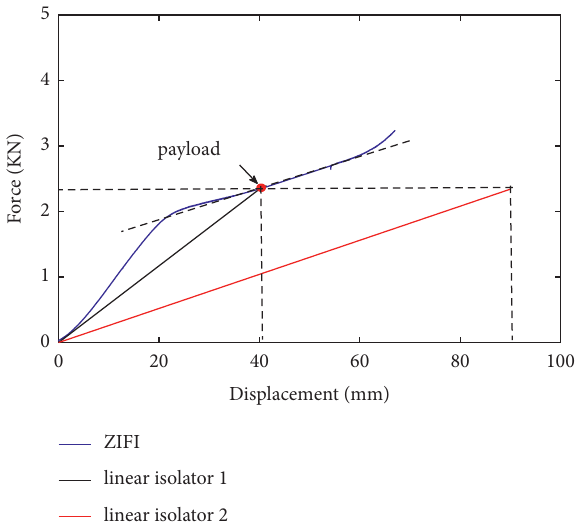
Figure 11: Comparison with linear vibration